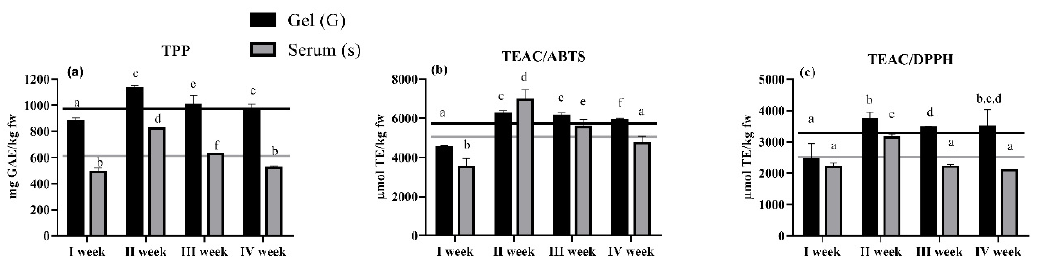
Figure 1. Total polyphenol content and antioxidant activity of gel (G) and serum (s) from Camone tomatoes sampled in four different weeks. ( a ) TPP (mean ± SD mg GAE/kg fw, n = 27); ( b ) and ( c ) AOA (mean ± SD μ mol TE/kg fw, n = 27) measured by TEAC/ABTS and TEAC/DPPH assays, respectively. Bars with different letters in each histogram, are significantly different (ANOVA with Tukey post ‐ test, p < 0.05). Horizontal lines represent mean values in the four weeks of sampling. TPP: Total polyphenol content; AOA: antioxidant activity; TEAC: trolox equivalent antioxidant capacity.